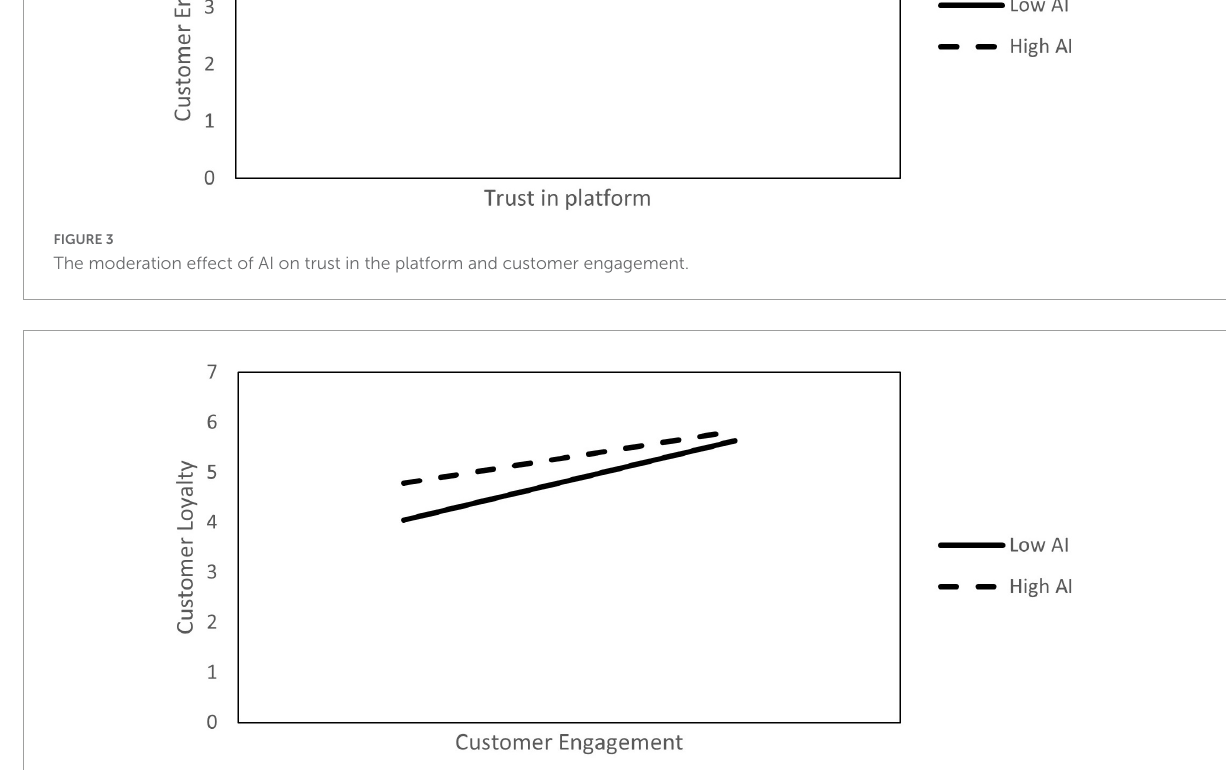
FIGURE4 The moderation effect of AI on customer engagement and customer